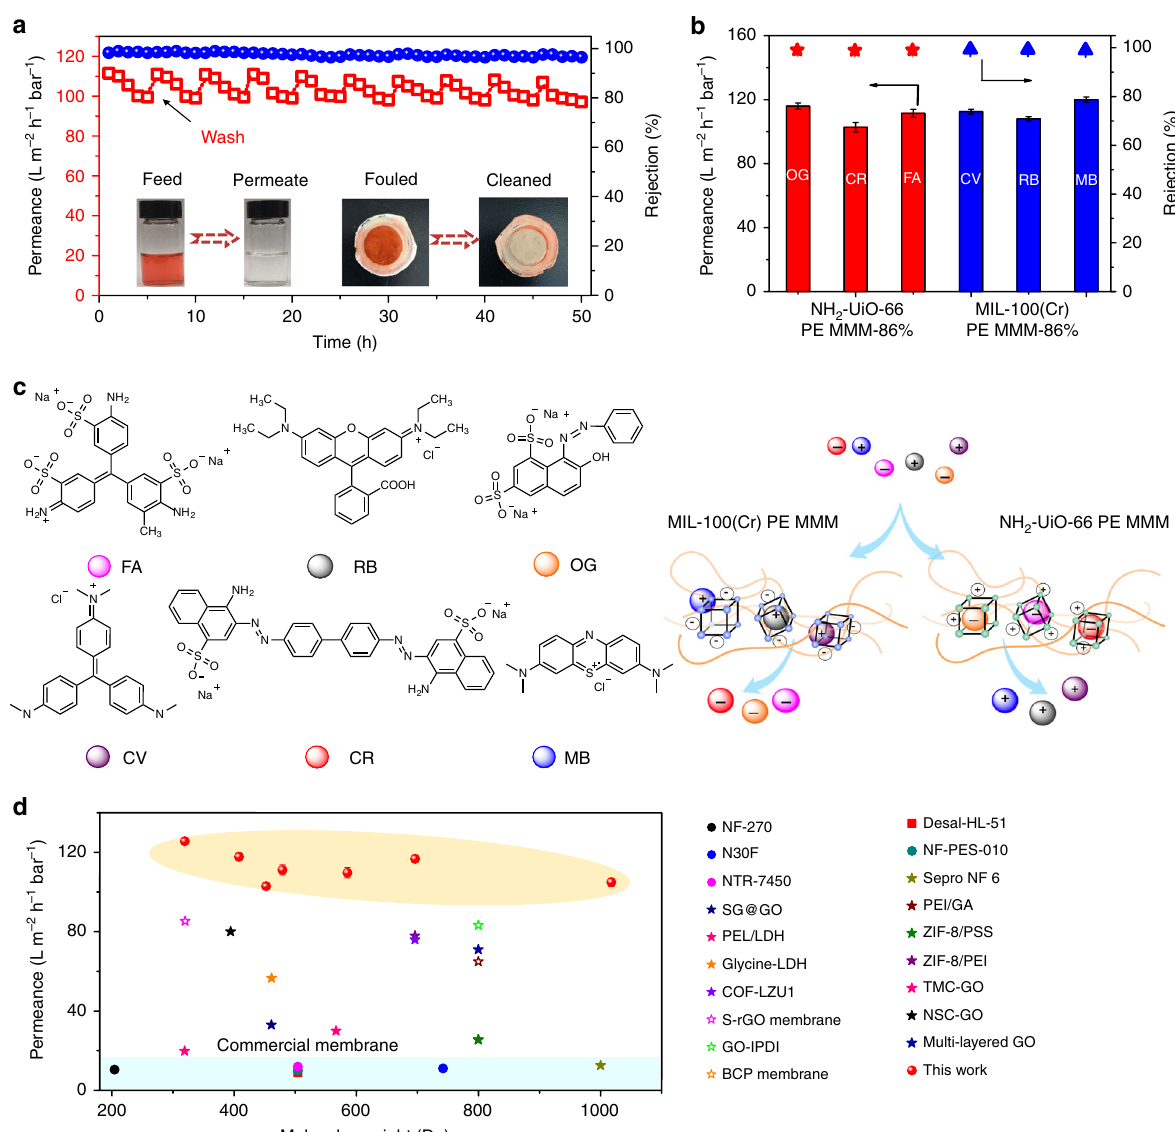
Fig. 3 MOF PE MMMs for dyes removal. a Antifouling performance and long-term stability of NH 2 -UiO-66 PE MMM-86% for the CR removal. The membrane was activated by washing with saturated NaNO 3 methanol solution in the cross- fl ow system during the cycles. b The separation performance of NH 2 -UiO-66 PE MMM-86% and MIL-100(Cr) PE MMM-86% for different dyes (concentration, 100 ppm; applied pressure is 0.2 MPa). c Schematic illustrations of the mechanism for dyes removal by MOF PE MMMs. d A performance comparison of NH 2 -UiO-66-MIL-100(Cr) PE MMM-86% with commercial and literature reported membranes. Error bars in b , d indicate the standard deviation of three independent